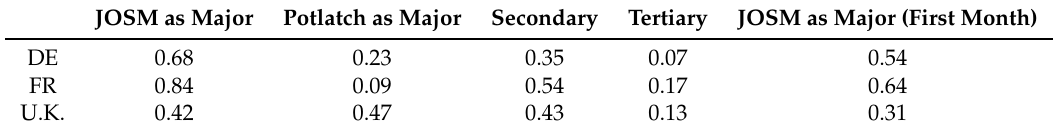
Figure 4. Major tools. Table 4. Skill